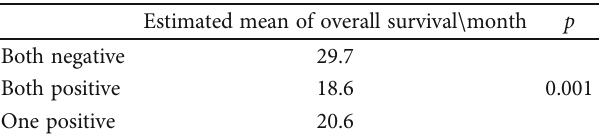
Table 8: DFS analysis of studied cases according to MALAT-1 and BACH